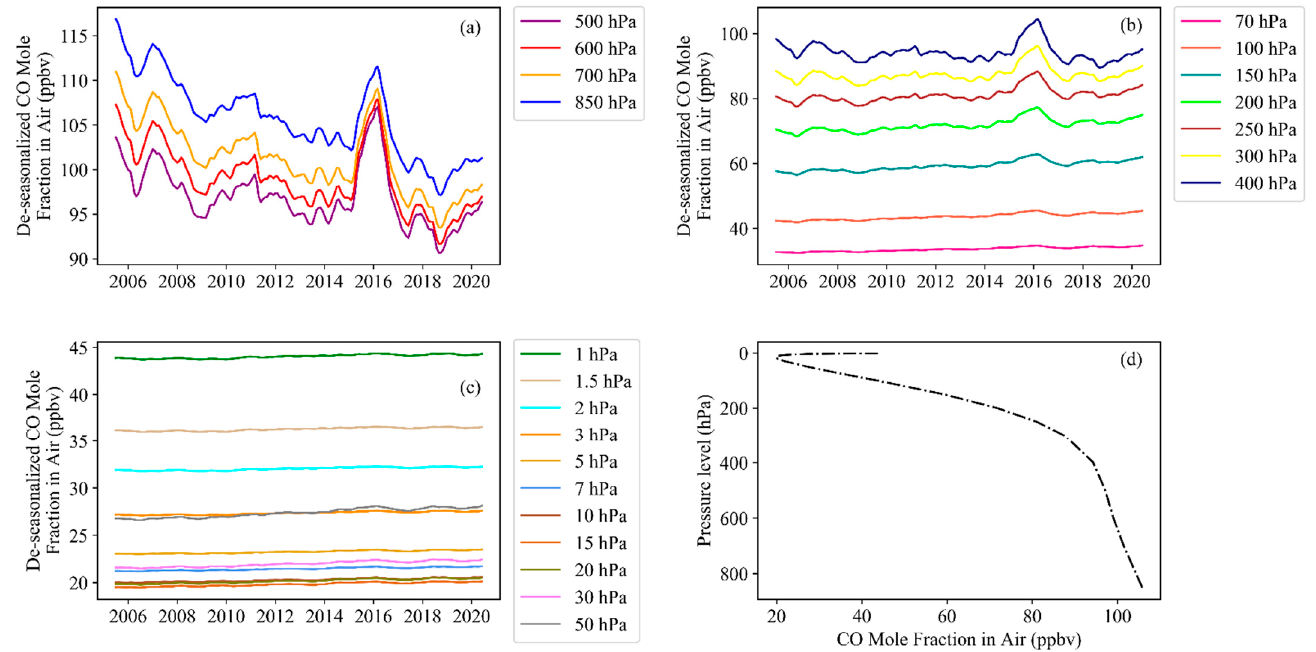
Figure 6. CO trend for 22 pressure levels in the atmosphere ( a – c ) along with the CO vertical profile ( d ) for the period 2005 to 2020.